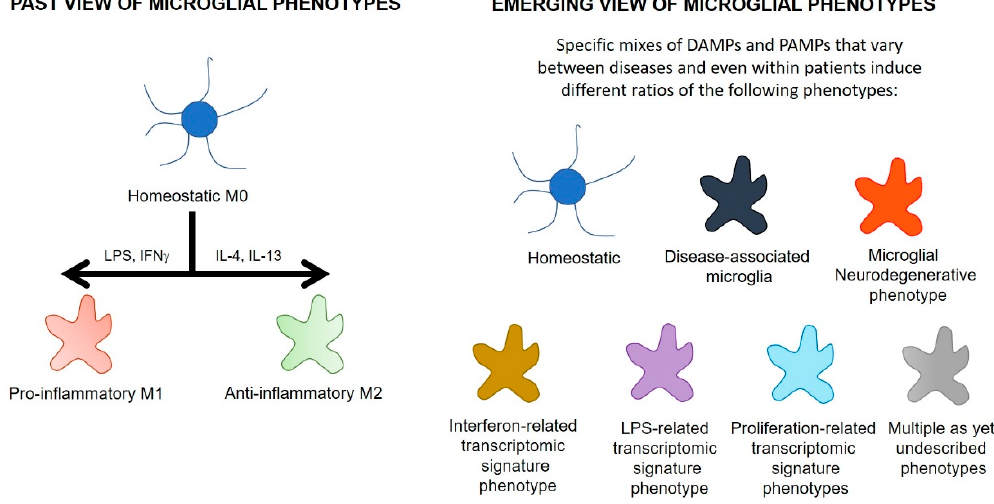
Figure 3. The changing paradigm of microglial phenotypes. DAMPs = danger-associated molecular patterns; PAMPs = pathogen-associated molecular patterns; LPS = lipopolysaccharide; IFN γ = interferon- γ , IL-4 = interleukin-4, IL-13 = interleukin-13.